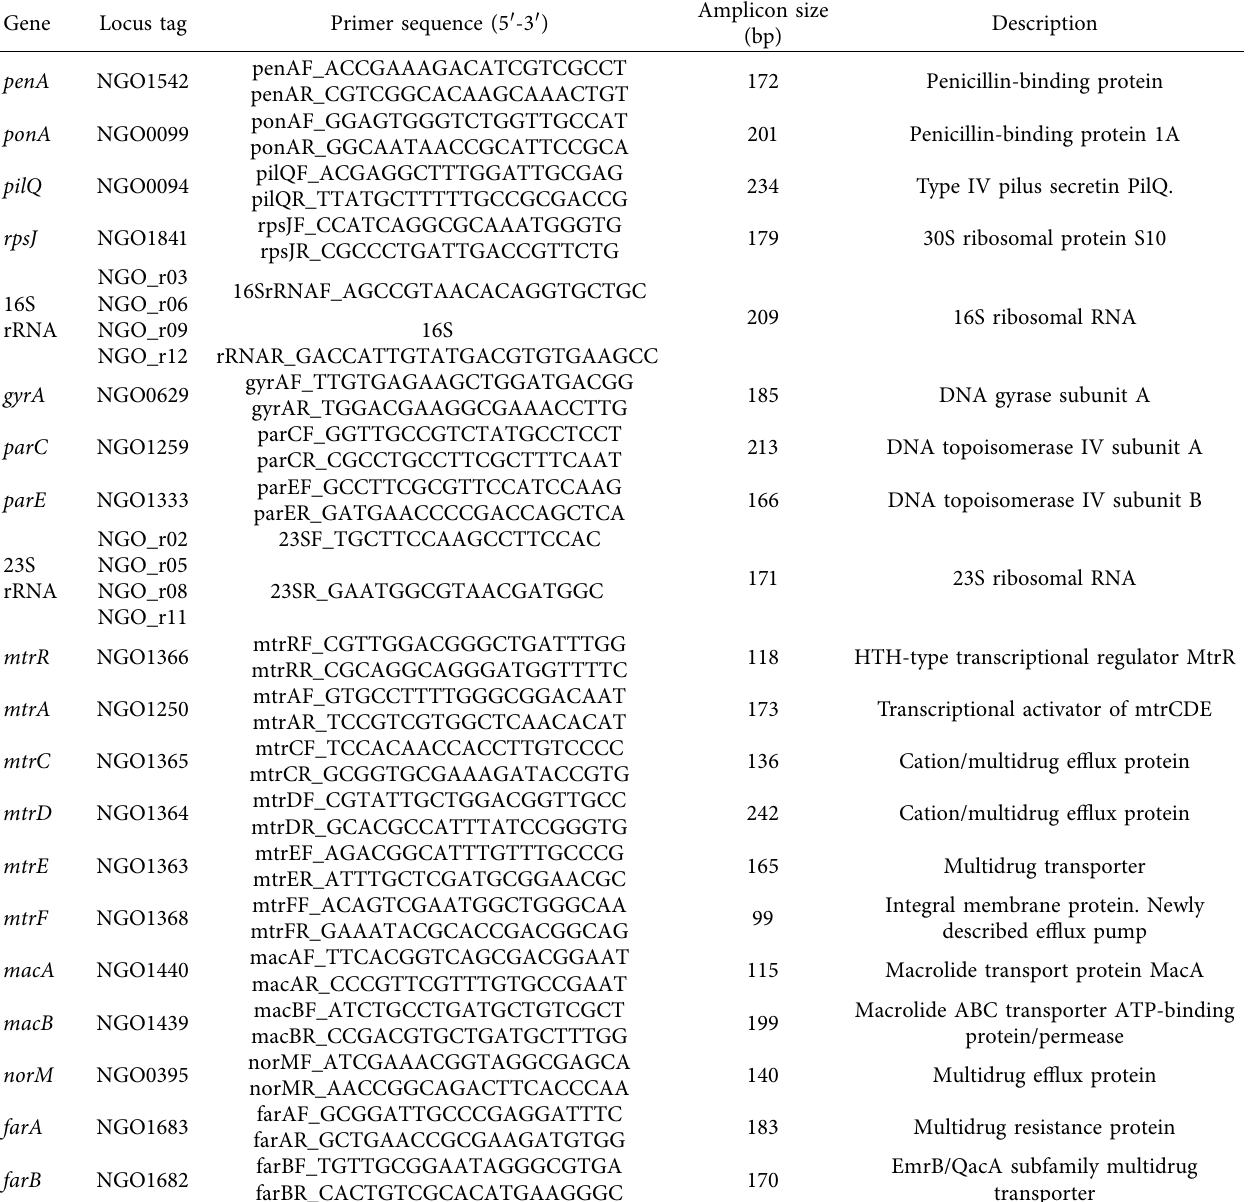
Table 1: Primers used for real-time